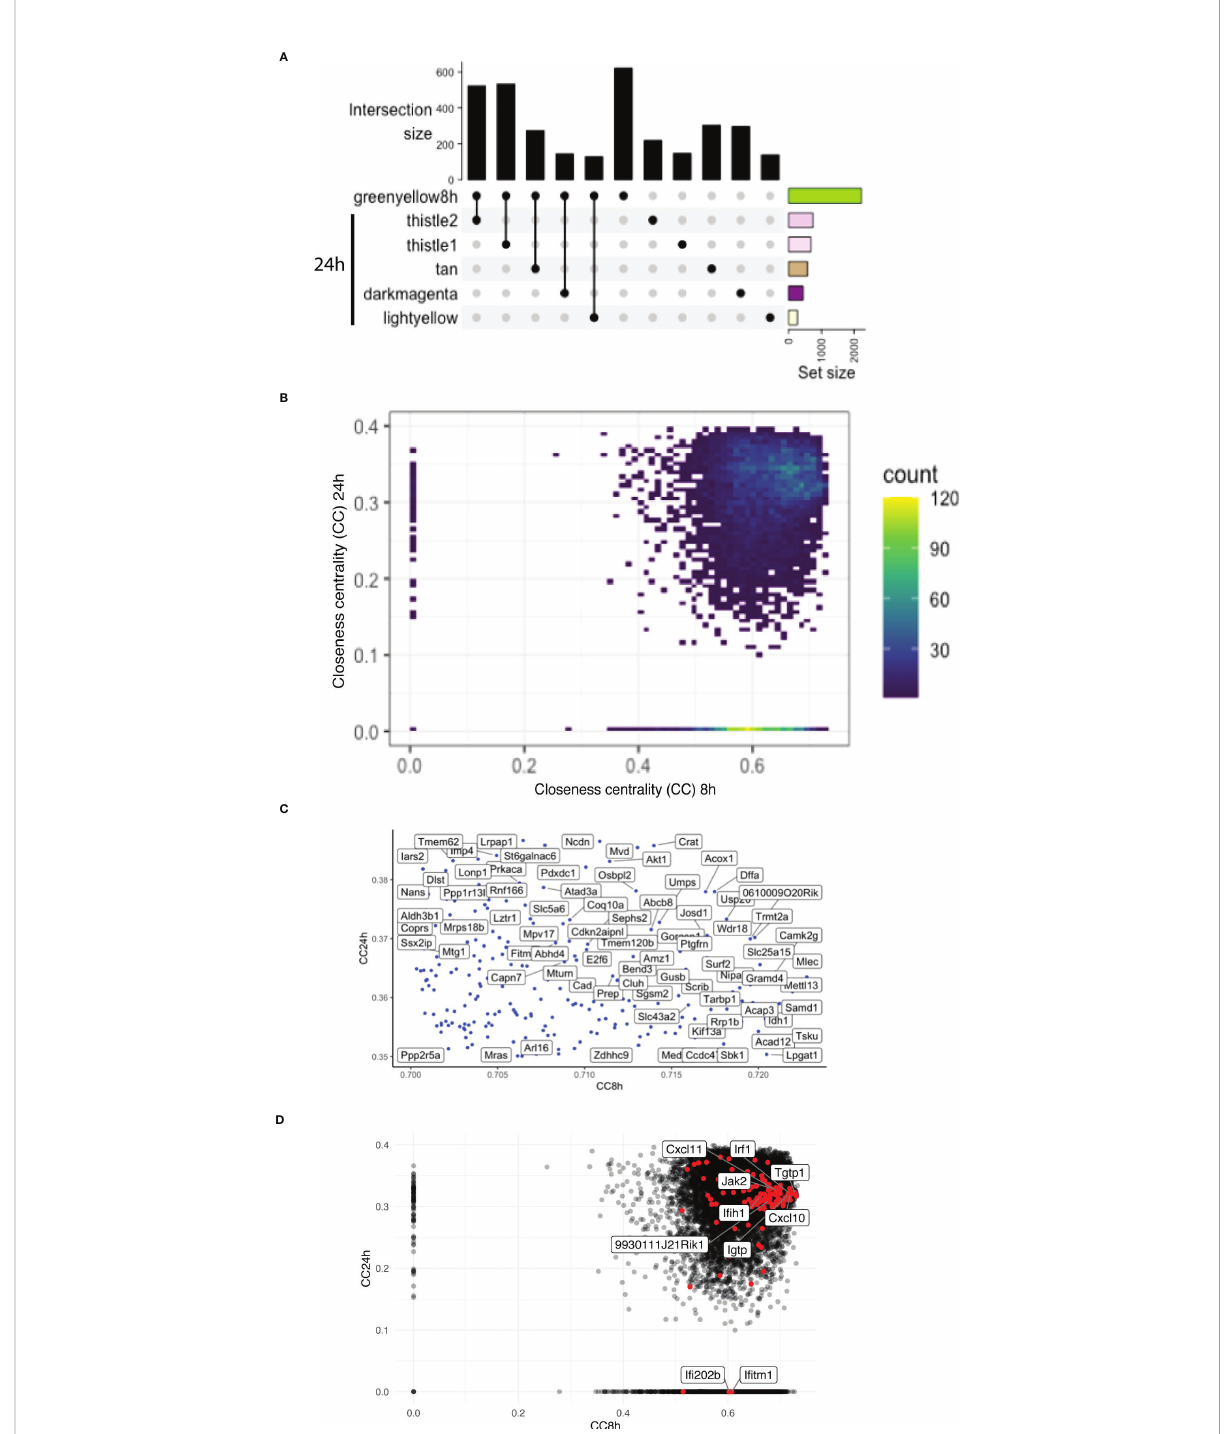
FIGURE 5 Overlap of highly connected modules at early and late time points uncovers the temporal dynamics of the interferon response. (A) An UpSet plot of the 8h_greenyellow module overlapping with the modules at the 24-h time point in WT + Ifnar-/- analysis. Top fi ve overlapping modules are shown. Intersection size is shown in the y-axis. The bottom-right part shows the total module size. (B) Density plot of the CC of genes in the WGCNA network at 8 h (x-axis) against 24 h (y-axis) in WT + Ifnar-/- analysis. Count unit corresponds to the number of genes in each rectangle. (C) Zoom of the tip of the CC plot. Genes with very high centrality at both 8 and 24 h p.i. (D) Scatter plot of CC of genes in the WGCNA network at 8 h (x-axis) against 24 h (y-axis) in WT + Ifnar-/- analysis. Positions of ISGs are highlighted in red and the names of 10 examples are